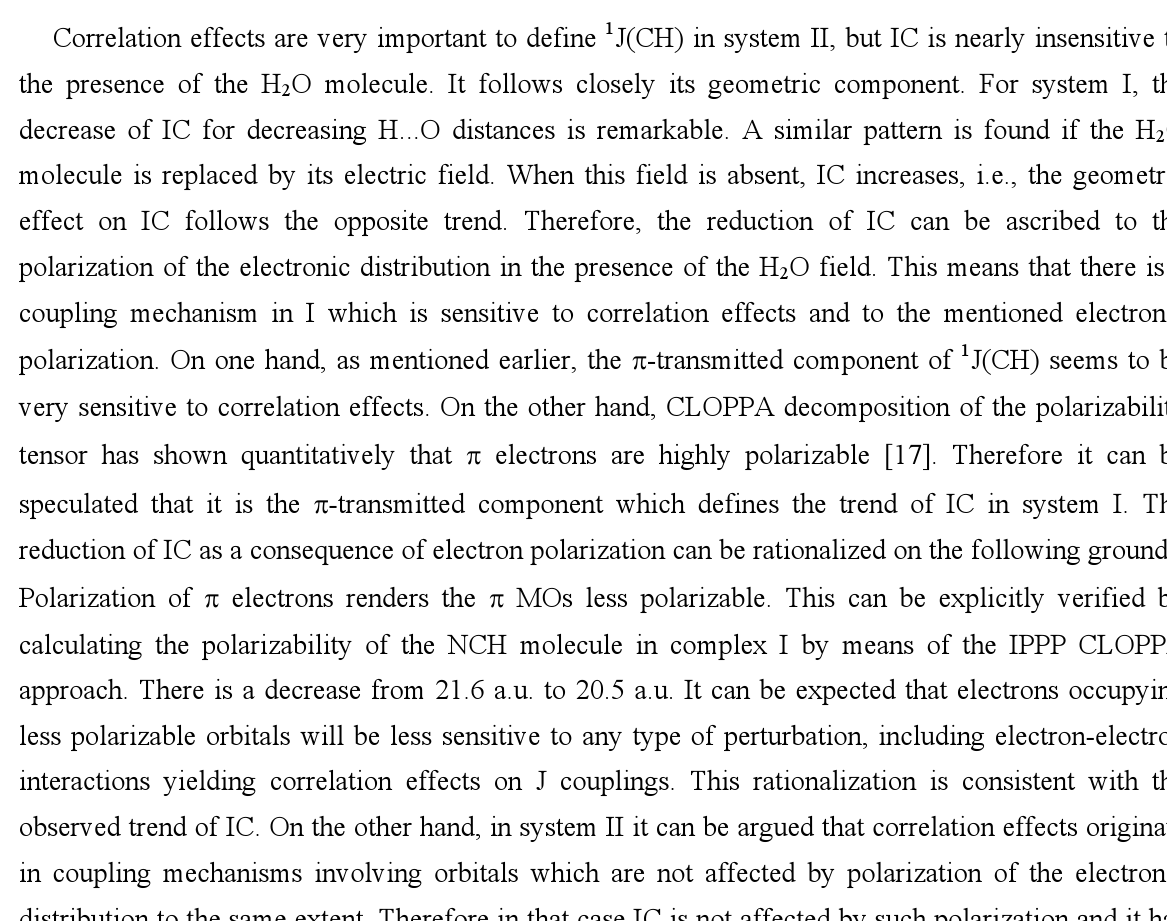
Figure 7. Correlation index for 1 J(CH), IC, in the NCH...OH isolated NCH and CH r(H...O). - (cid:81) - IC (NCH...OH indicate the equilibrium distance in each